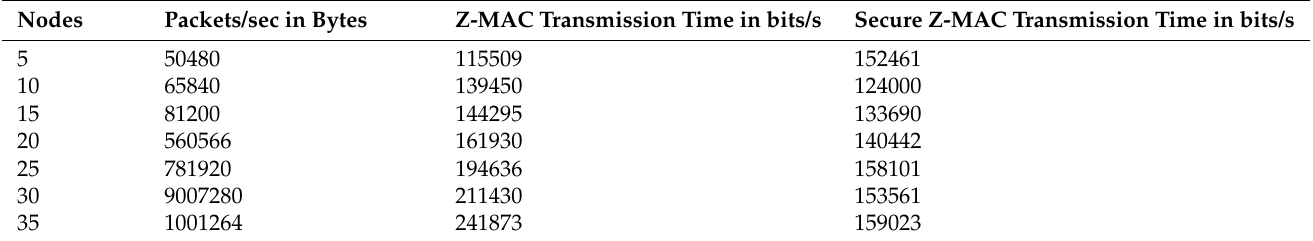
Table 9. Total transmission time during a DDOS attack for nodes processed using the secure ZMAC scheme compared to